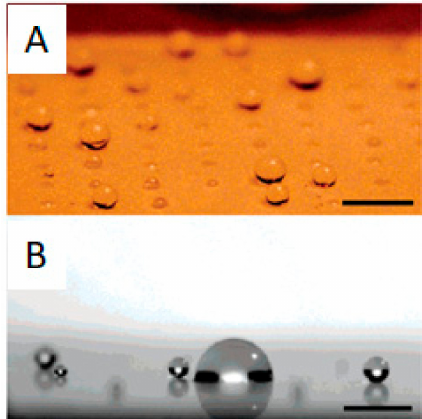
Figure17. ( A )Waterdropletswithdi ff